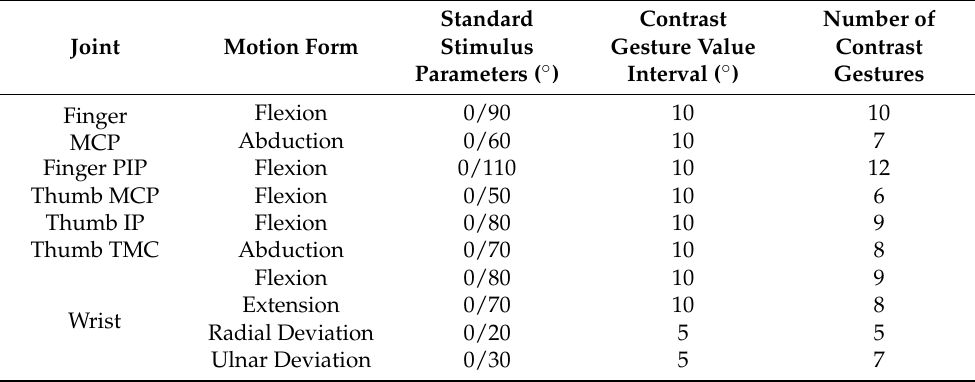
Table 2. Stimulation configuration for Experiment